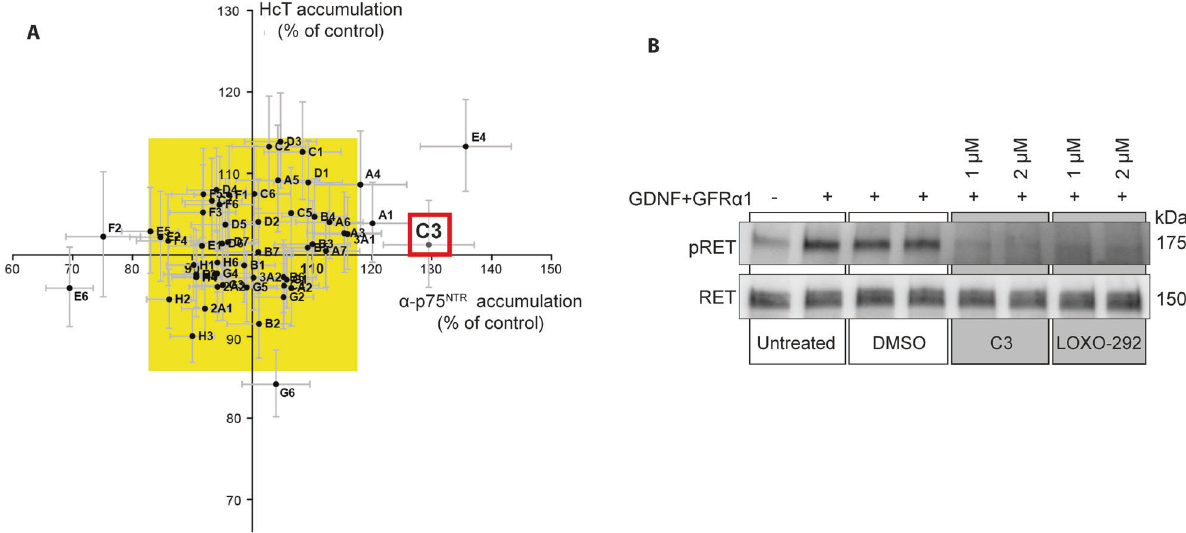
Fig. 1 A kinase inhibitor screen identi fi ed C3, a RET inhibitor, as an enhancer of axonal transport. A Summary of results from a kinase inhibitor pilot screen [4]. The graph represents the accumulation of a fl uorescent binding fragment of tetanus neurotoxin (H C T) and a fl uorescently conjugated antibody directed against the p75 NTR neurotrophin receptor ( α -p75 NTR ) in ES-derived MNs following incubation with 2 μ M of the different compounds. The yellow box shows a threefold average standard deviation of the entire data set. Compounds falling outside the yellow box in the upper right quadrant signi fi cantly enhanced accumulation. A1, A4 [4], E4 [20] and C3 were identi fi ed as potential transport enhancers. B Representative western blot of SH-SY5Y cell lysates following treatment with recombinant GDNF and GFR α 1, the RET inhibitors (C3 and LOXO-292), and their vehicle control, DMSO. SH-SY5Y cells were pre-treated with DMSO, 1 or 2 µM C3 or LOXO-292 for 1 h, and stimulated with 100 ng/ml GDNF and GFR α 1 for the fi nal 10 min of